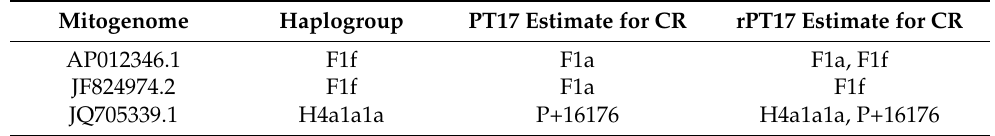
Table 4. Differences of haplogroup estimates in the